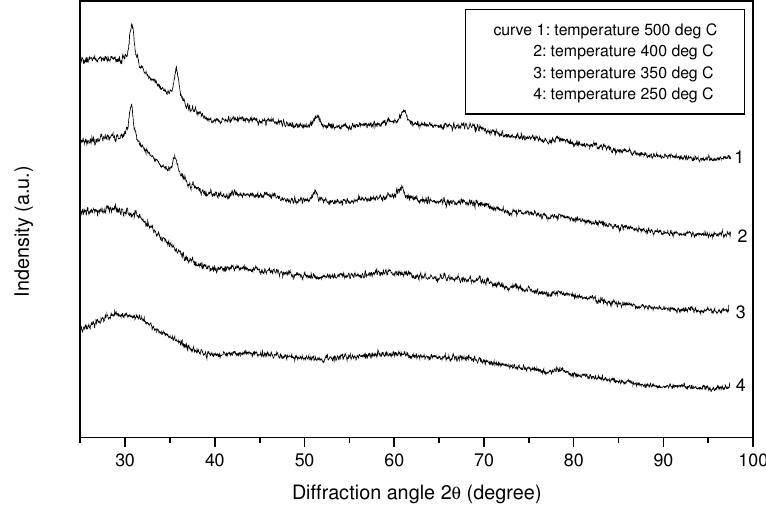
Figure 2 . XRD results of samples prepared by different annealing time intervals (t=10min and t=45min)